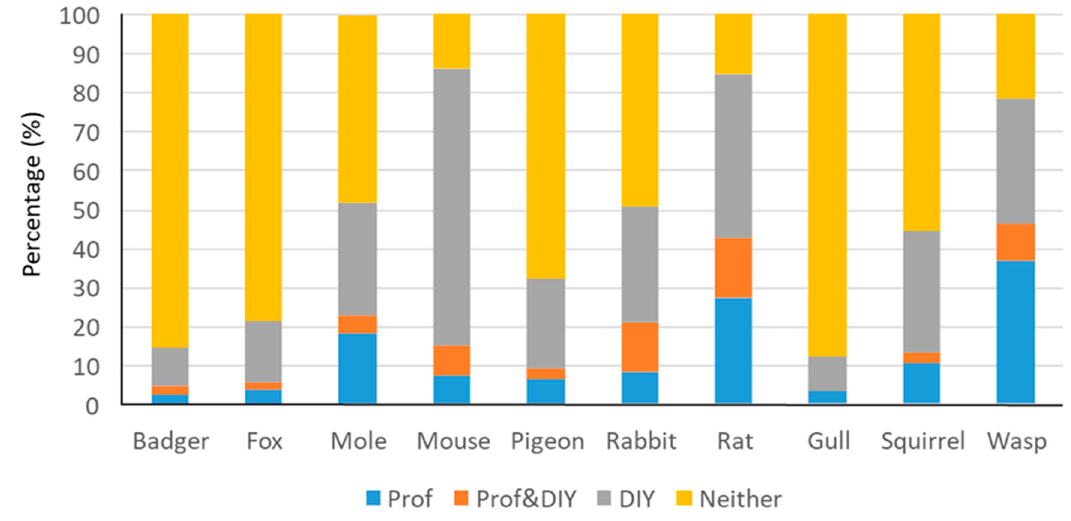
Figure 6. Control actions taken against 10 species where a problem was experienced in the past. Prof = Professional control service only, Prof&DIY = Professional control service and Do-It-Yourself control, DIY = Do-It-Yourself control only (percentage of people reporting, n values: badger = 41, fox = 177, mole = 118, mouse = 622, pigeon = 185, rabbit = 47, rat = 438, gull = 120, squirrel = 132, wasp = 688).